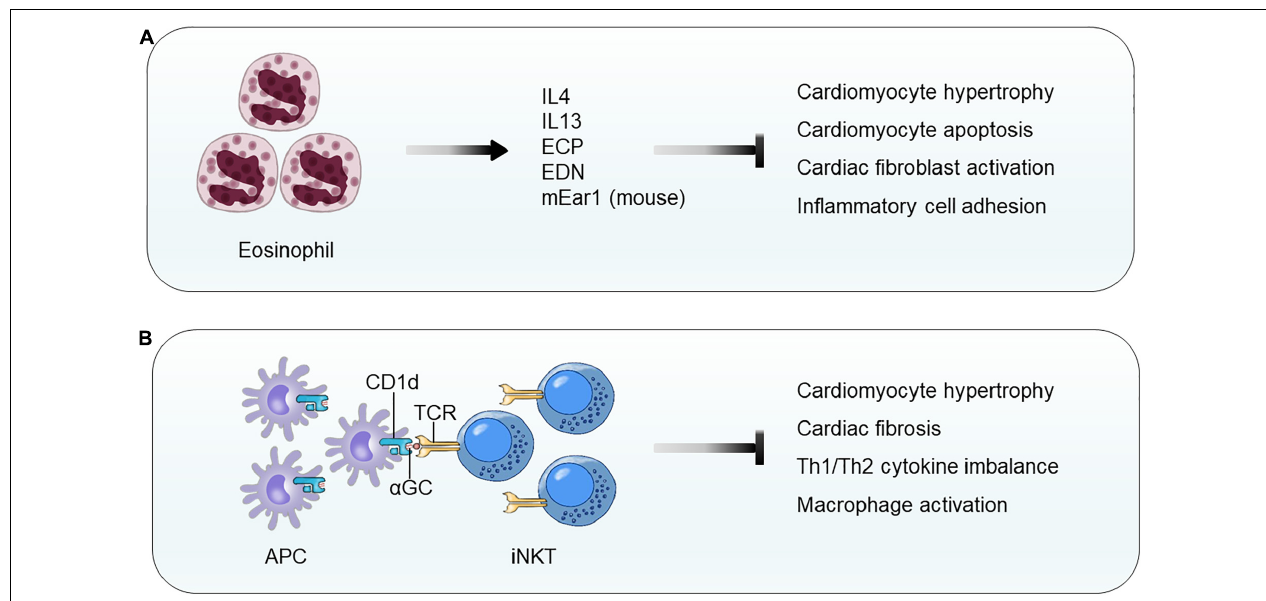
FIGURE 6 | Eosinophil and invariant natural killer T-cell function in pressure overload-induced cardiac hypertrophy and fibrosis. (A) EOS release cytokines (IL4 and IL13) and cationic proteins (e.g., human ECP, human EDN, and mouse mEar1) to block cardiomyocyte hypertrophy and apoptosis, cardiac fibroblast activation, and inflammatory cell adhesion and migration. (B) CD1d- α GC-mediated activation of iNKT cells blocks cardiomyocyte hypertrophy and apoptosis, Th1/Th2 cytokine imbalance, and macrophage